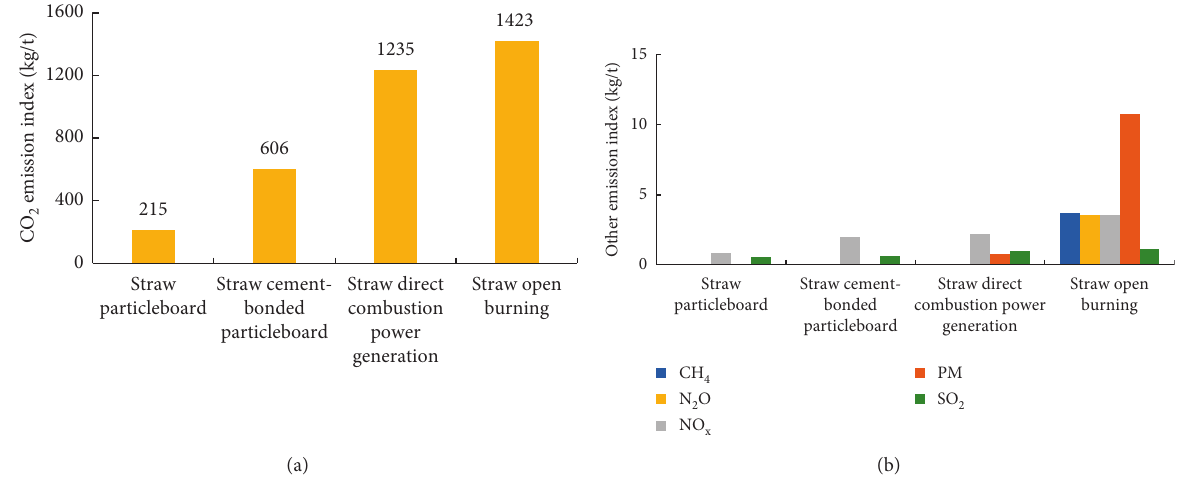
2 emission index and (b) comparisons of